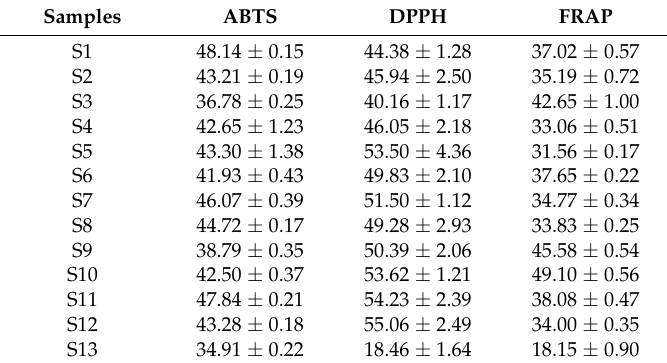
Table 6. The antioxidant activity of collagen peptides in the 2,2 (cid:48) -Azinobis (3-ethylbenzothiazoline- 6-sulphonic acid) diammonium salt (ABTS) assay, the 2,2-diphenyl-1-picrylhydrazyl (DPPH) assay, and the ferric-reducing antioxidant power (FRAP) assay.